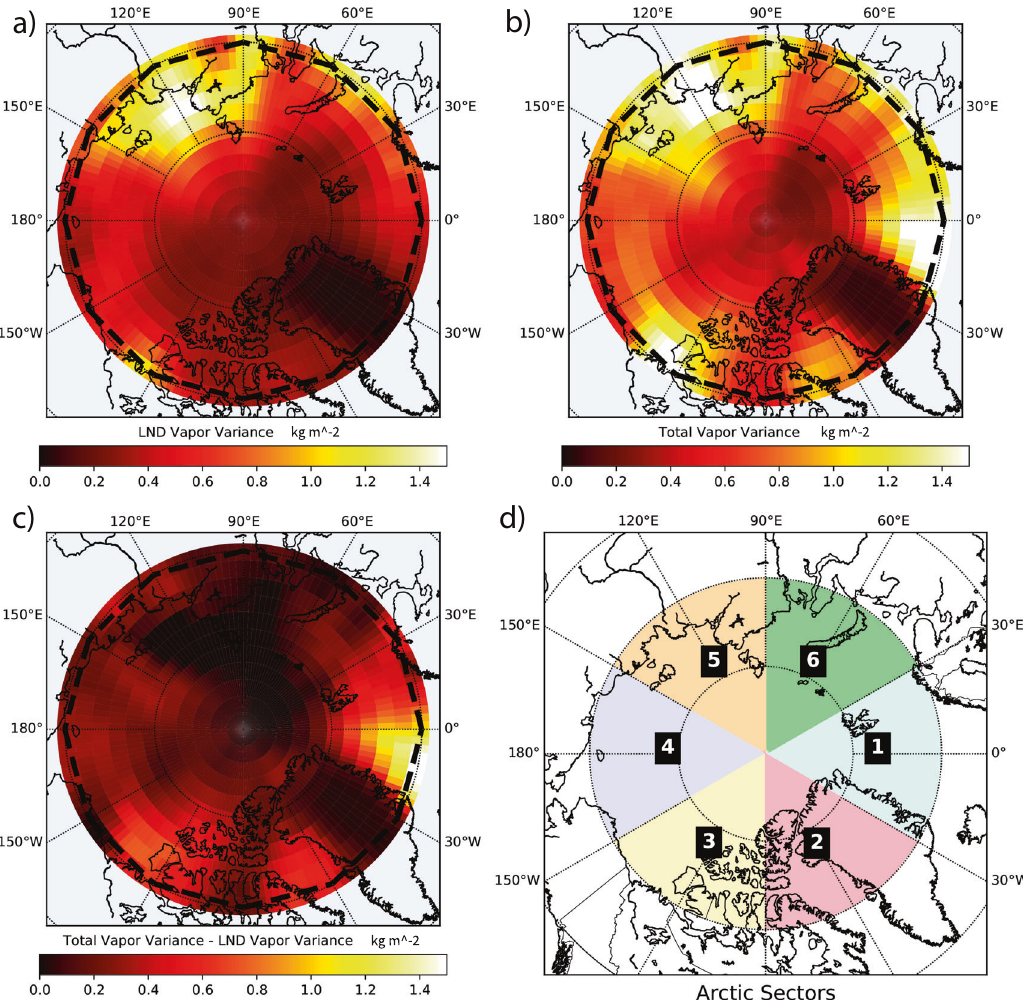
Fig. 3 Comparison of summer integrated vapor variances. Variance in a integrated land vapor, b total integrated vapor, and c the difference between a and b . d De fi nitions of the Arctic sectors used to study regional variations in vapor concentration. The black dashed line at 69° latitude marks the Arctic extent. Units are (kg m − 2 ) 2